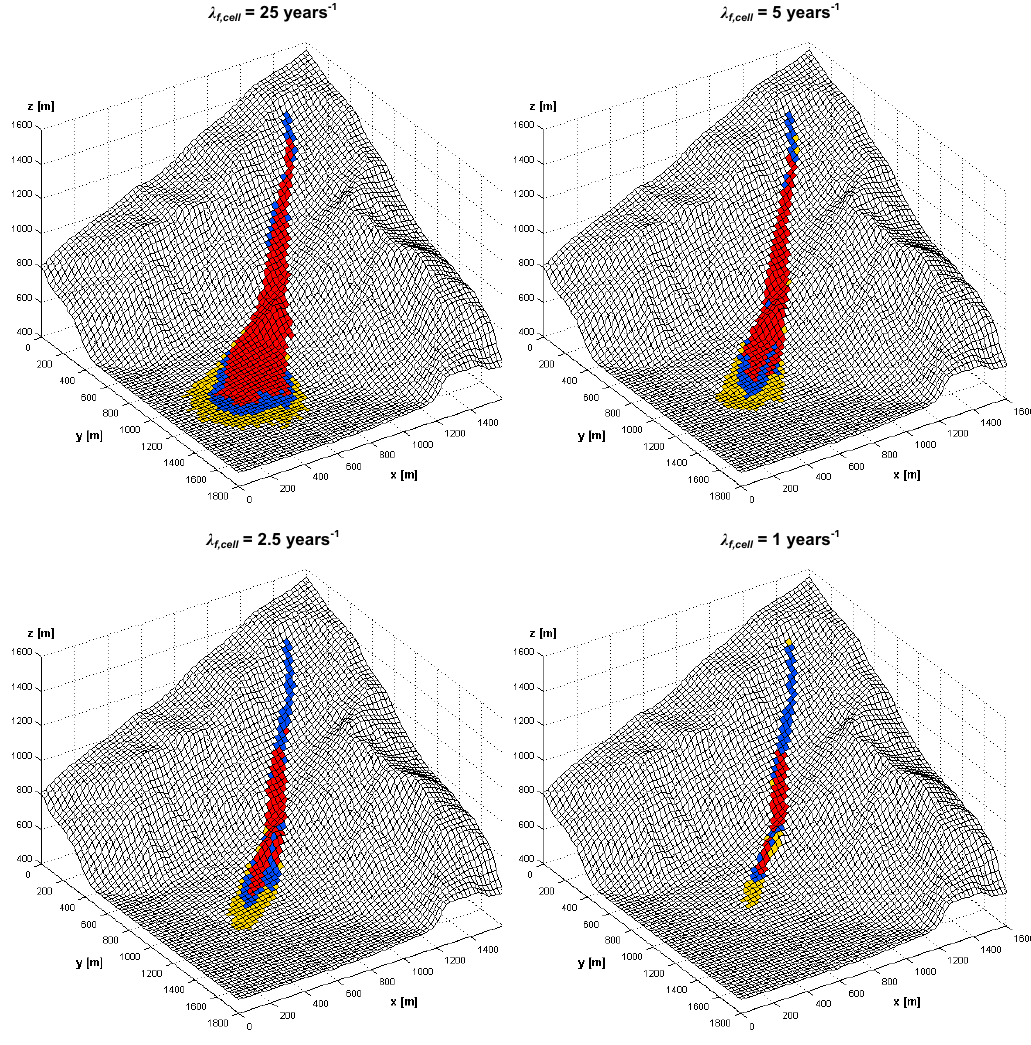
Fig. 14. Influence of a change in the rock fall frequency of failure on hazard zoning. The zoning was performed for failure frequencies of Figure 14. Influence of a change in the failure frequency of failure on hazard zoning. The zoning =0.04 [years -1  m -2 ] (i.e. λ =25 years -1 ), λ =0.008 [years -1  m -2 ] (i.e. λ =5 years -1 ), 0.004 [years -1  m -2 ] (i.e. λ λ f,2D f,cell f,2D f,cell (i.e. λ =1 years -1 ). was performed for failure frequencies of λ f, 2 D = 0.04 (years − 1 · m − 2 ) (i.e., λ f,cell = 25 years − 1 ), f,cell λ = 0.008 (years − 1 · m − 2 ) (i.e., λ = 5 years − 1 ), 0.004 (years − 1 · m − 2 ) (i.e., λ f, 2 D f,cell and 0.0016 (years − 1 · m − 2 ) (i.e., λ f,cell = 1 years − 1